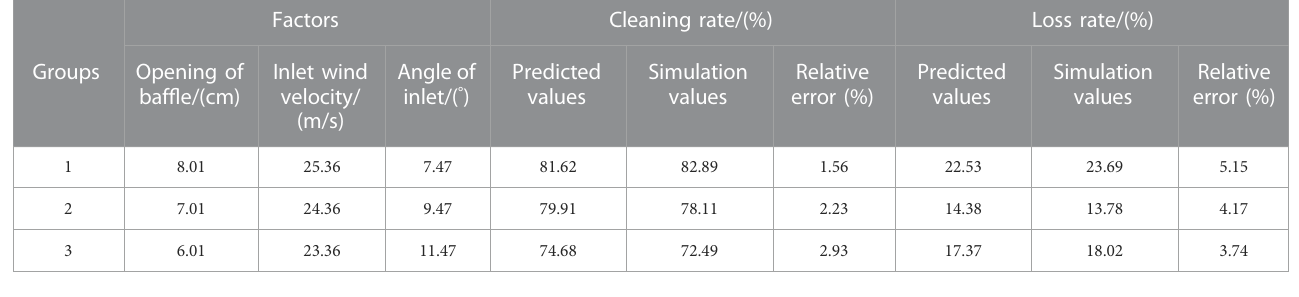
TABLE 5 Comparison test group.